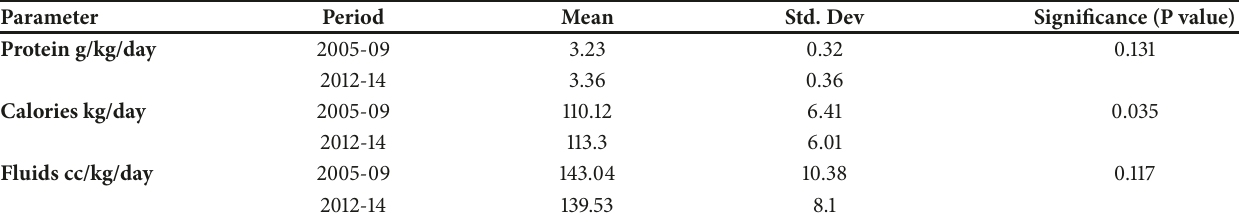
Table 4: Nutritional intake after regaining birth weight to the time of discharge.